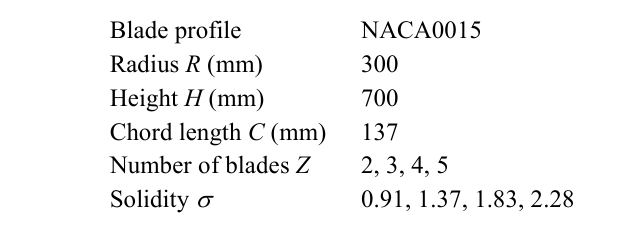
Specifications of rotor